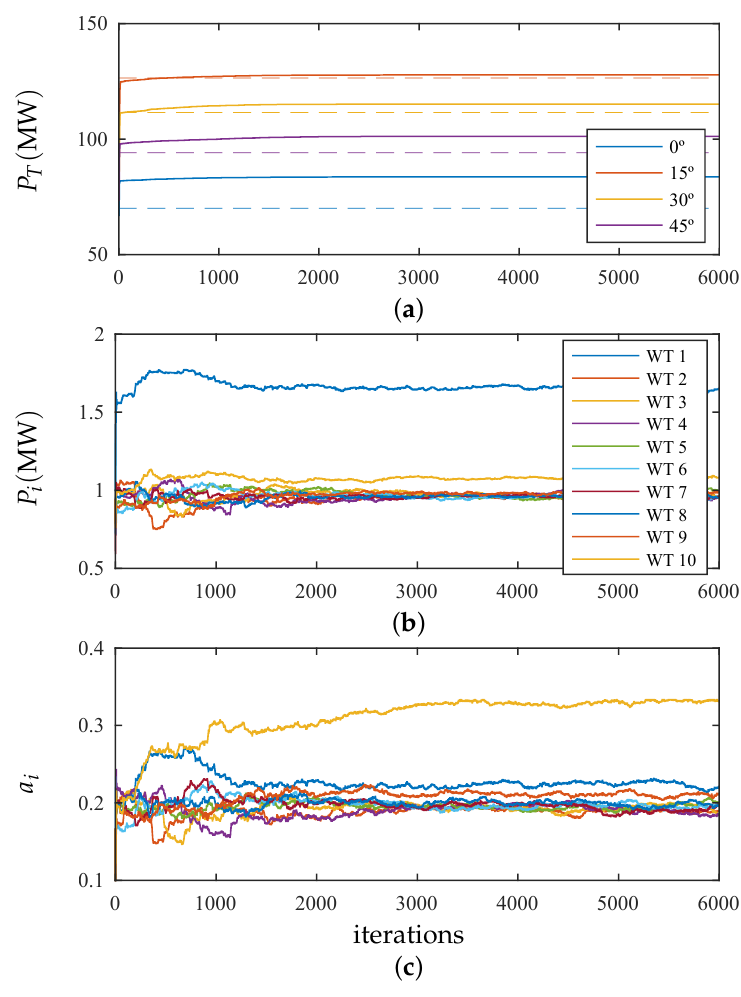
Figure 7. ( a ) Total powers for scenario 1 (free-stream wind speed of 10 m/s) for four wind speed directions. ( b ) Power generated by wind turbines 1–10 and with wind direction of 45 ◦ . ( c ) Axial coefficients for wind turbines 1–10 and with wind direction of 45 ◦